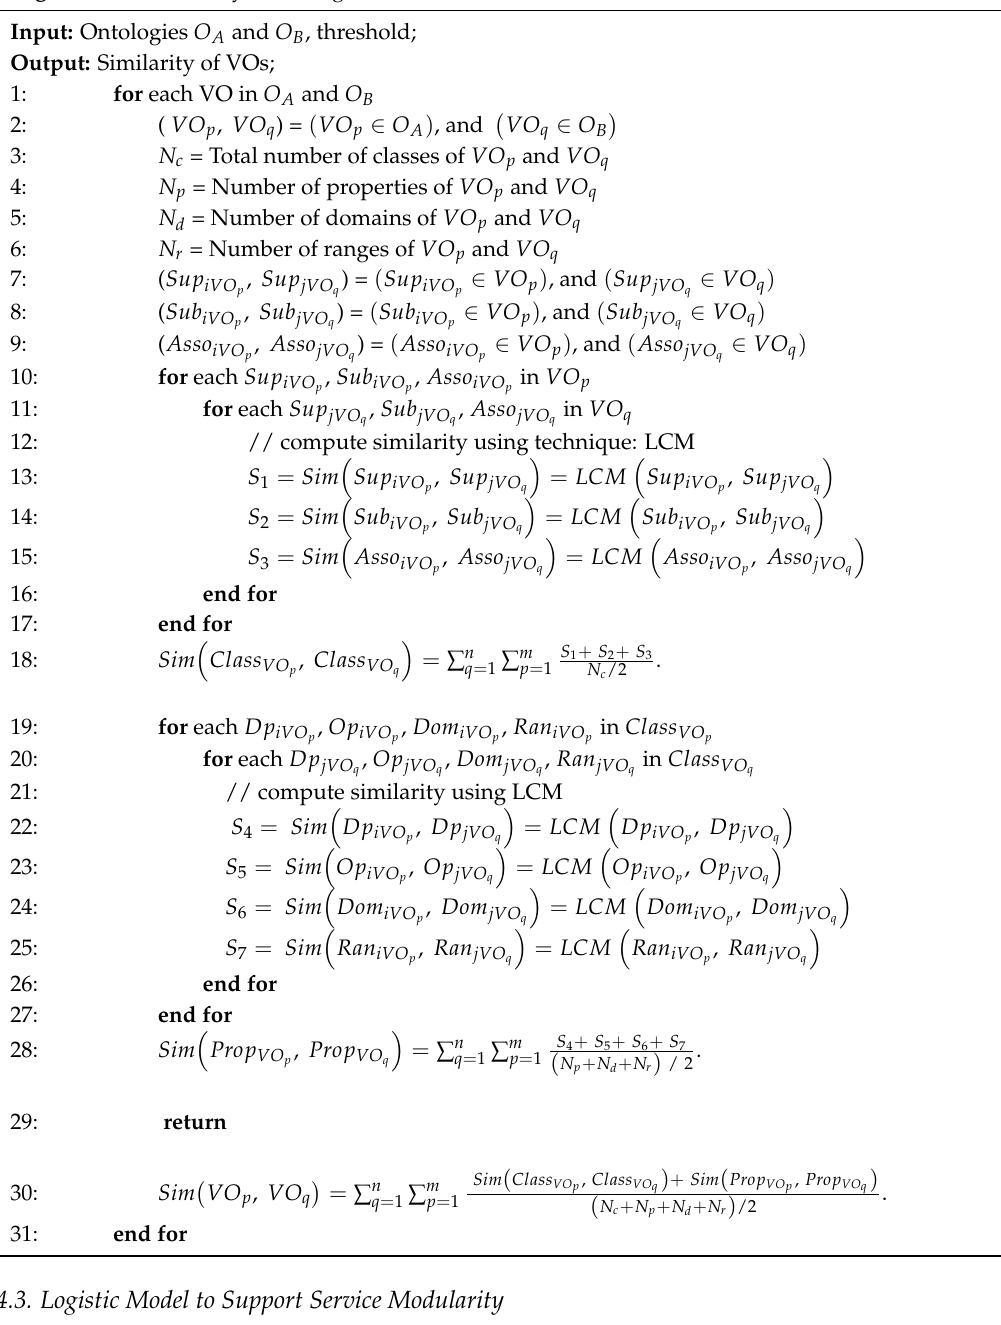
Algorithm 1. Similarity